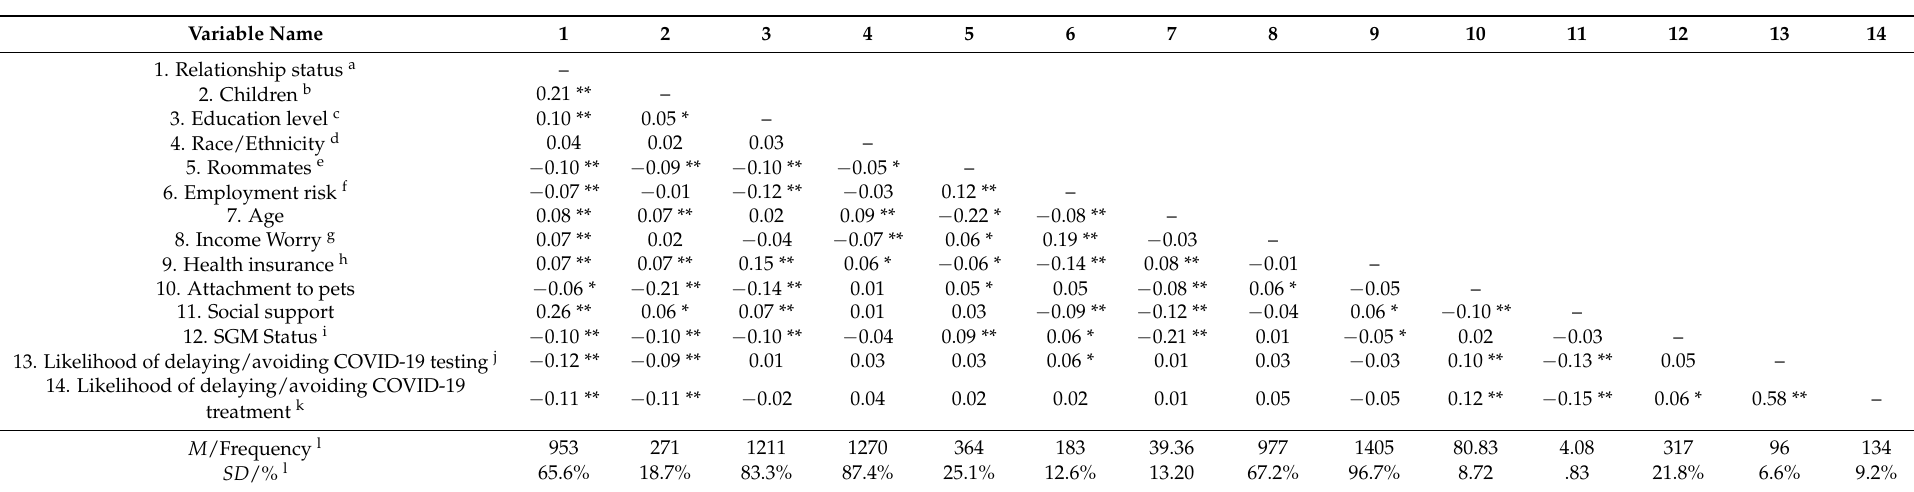
Table 2. Intercorrelations between key variables (N =